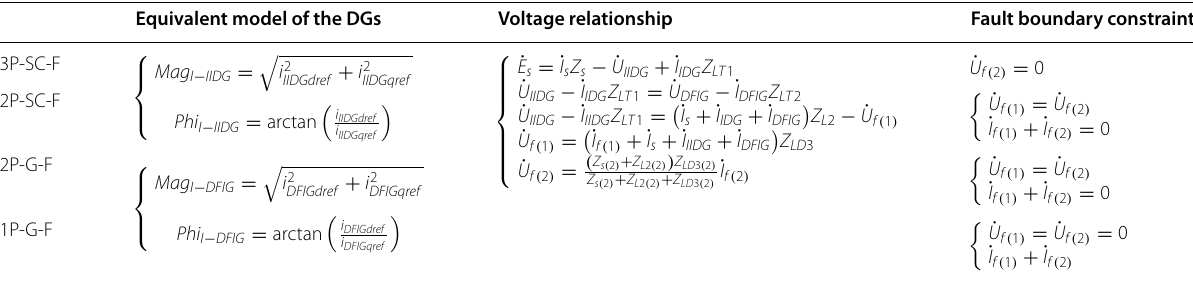
Table 2 Objective function under different fault conditions Equivalent model of the DGs Voltage relationship Fault boundary constraints 3P‑SC‑F